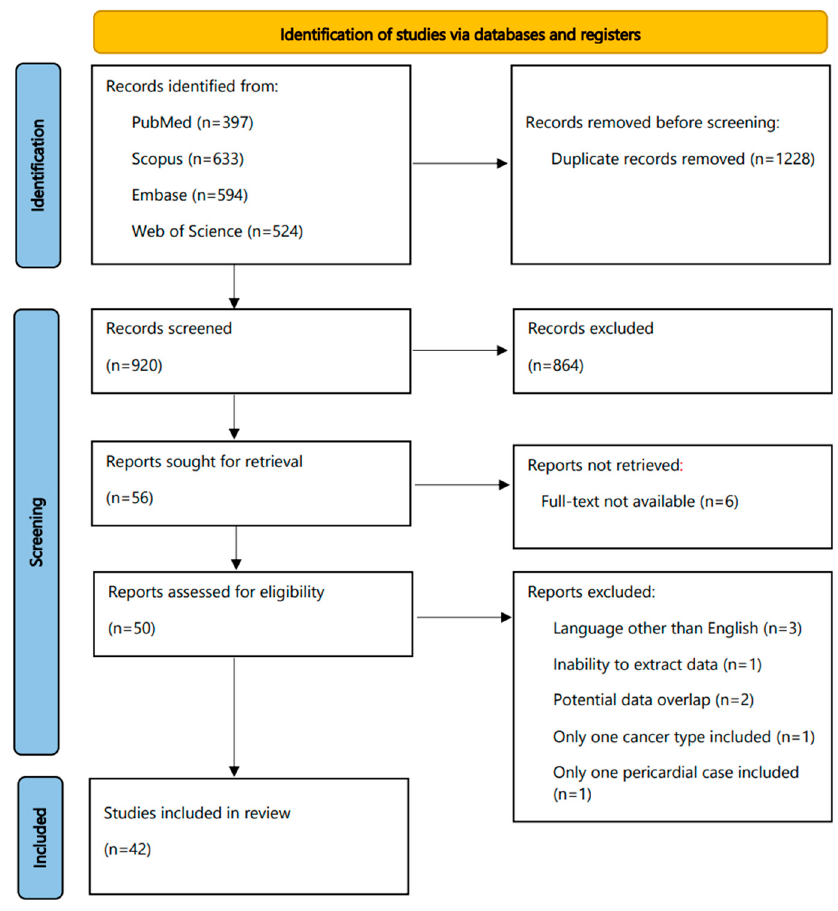
Figure 1. Flowchart of this systematic review.